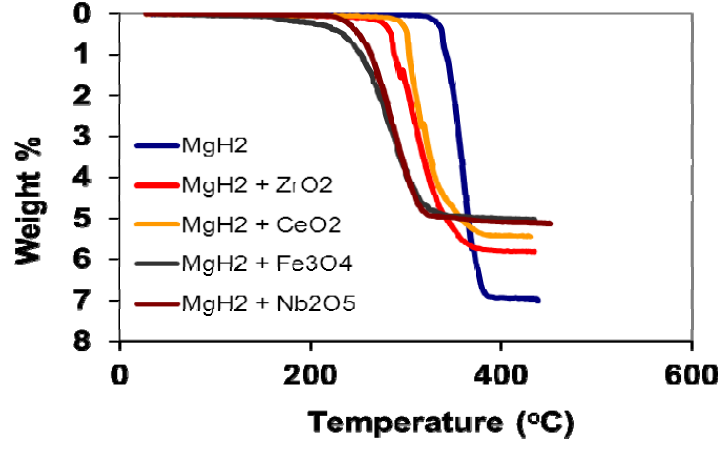
Figure 1. Temperature Programmed Desorption (TPD) profiles for MgH MgH materials. 2